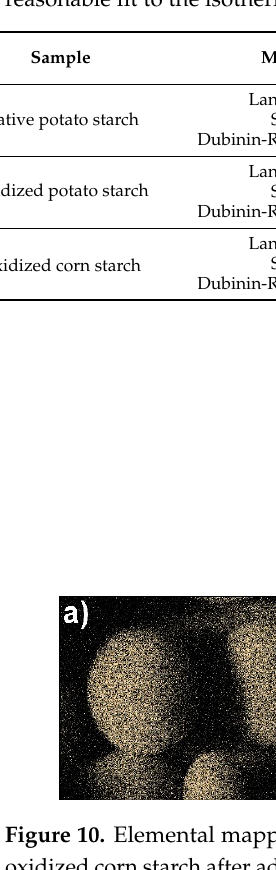
Table 5. Fitting parameters for Langmuir, Sips, and Dubinin-Radushkevich isotherm models for native potato starch, oxidized potato starch, and oxidized corn starch for adsorption from CdSO 4 solution. Q m thereby is the maximal sorption capacity, K is the equilibrium constant for the respective model, n is the Sips isotherm model exponent, and E ads,DR is the mean free energy of adsorption derived from the Dubinin-Radushkevich model. None of the applied models gave a reasonable fit to the isotherm of native corn starch.